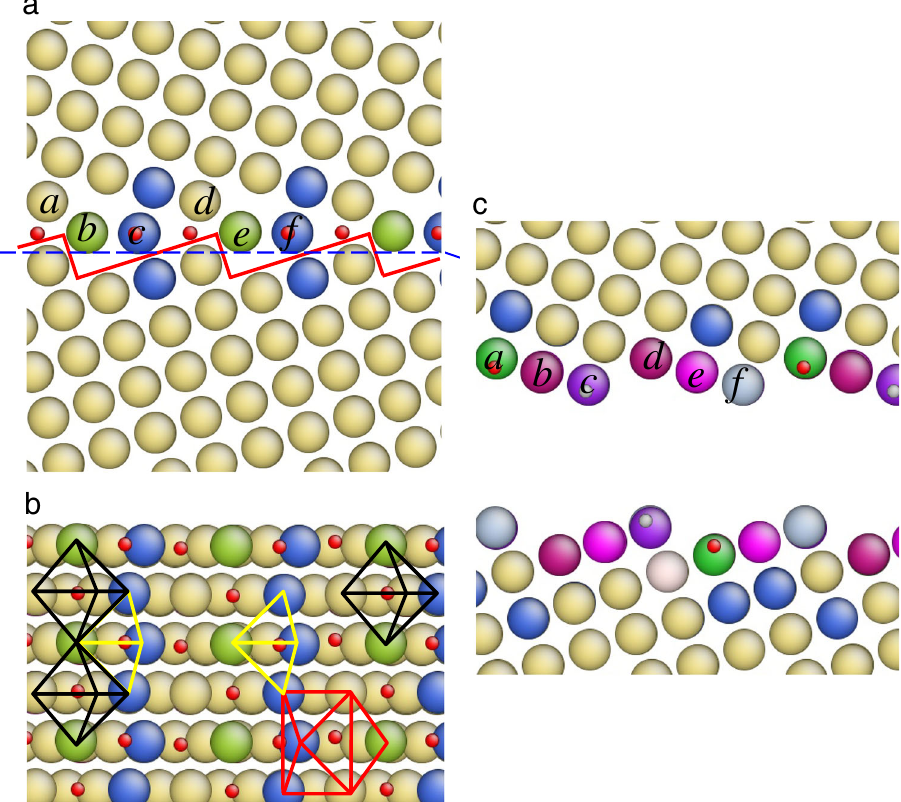
Fig. 3 Atomic structures of the ∑ 5(310)[001] GB with a full H coverage before and after fracture. a The side view of the relaxed GB before fracture, with all the deltahedral holes occupied by interstitial H atoms, and b the corresponding cross-sectional view (cut through the blue dashed line in a ). The colored polyhedra in b indicate the different packing units at the GB (see de fi nitions in Fig. 1). c The relaxed structure of the fractured GB; the cleavage plane is indicated by the red solid line in a ; surface atoms are marked by a – f for fi nding the counterparts in a . Atoms are colored by the coordination number